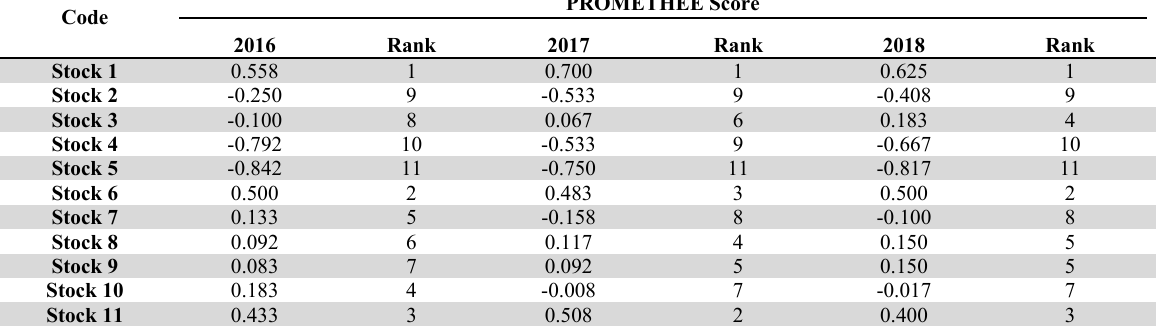
Ranking Results without Sustainable Certification and Risk